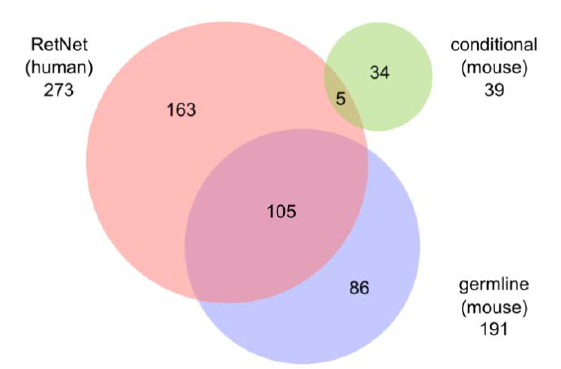
Figure 7. Comparison of the number of RD genes identified in human (RetNet) and mouse as listed in Table S1 and summarized in Figure 3. The total number of genes in the RetNet database that cause monogenic disease and have mouse homologs is indicated, as is the total for which conditional or germline mutations have been associated with PR cell loss in mice, as described in this review. Numbers within the overlapping areas of the diagram represent genes present in both RetNet and Table S1; the remaining numbers represent genes that are unique to the indicated category.